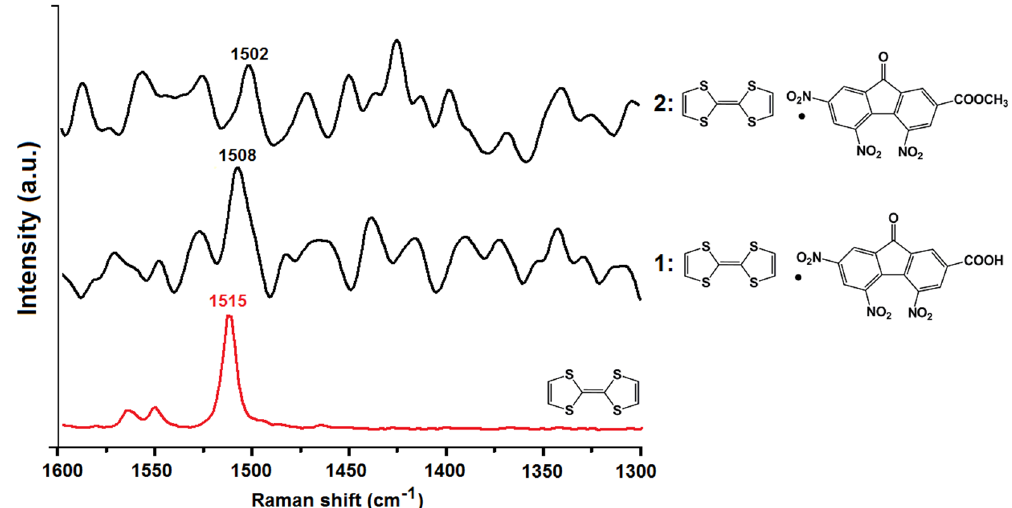
Figure 4. Raman spectra in the 1300–1600 cm − 1 range for neutral TTF and CT complexes 1 and 2